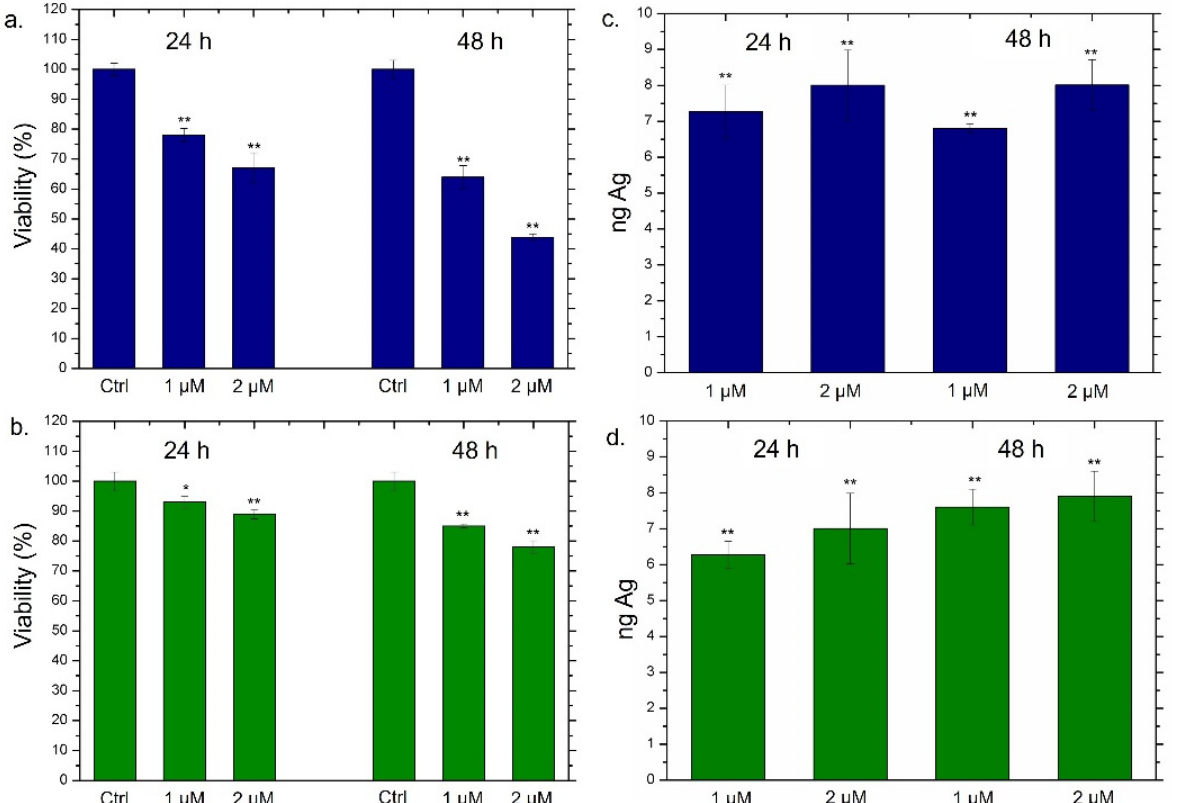
Figure 4. ( a , b ) Viability assay performed on THP-1 cell lines exposed to 1 µ M and 2 µ M of conven- tional Ag NPs ( a ) and green Ag NPs ( b ) after 24 h and 48 h. The viability of cells exposed to NPs was normalized to control cells (untreated). As a positive control (P), 5% of DMSO was used (data not shown). Data reported as the mean ± SD from three independent experiments are considered statisti- cally significant, compared with the control (n = 8) for p -value < 0.01 (<0.01 **) and < 0.05 (<0.05 *). ( c , d ) Uptake of conventional Ag NPs ( c ) and green Ag NPs ( d ) in THP-1 cell lines at concentrations of 1 µ M and 2 µ M for 24 h and 48 h. Untreated cells represented the controls (values = 0, data not shown). The data were reported as the mean ± SD from three independent experiments. Data were statistically significant in comparison to exposed cells vs. control cells (ag content is equal to 0) for p -value < 0.01 (<0.01